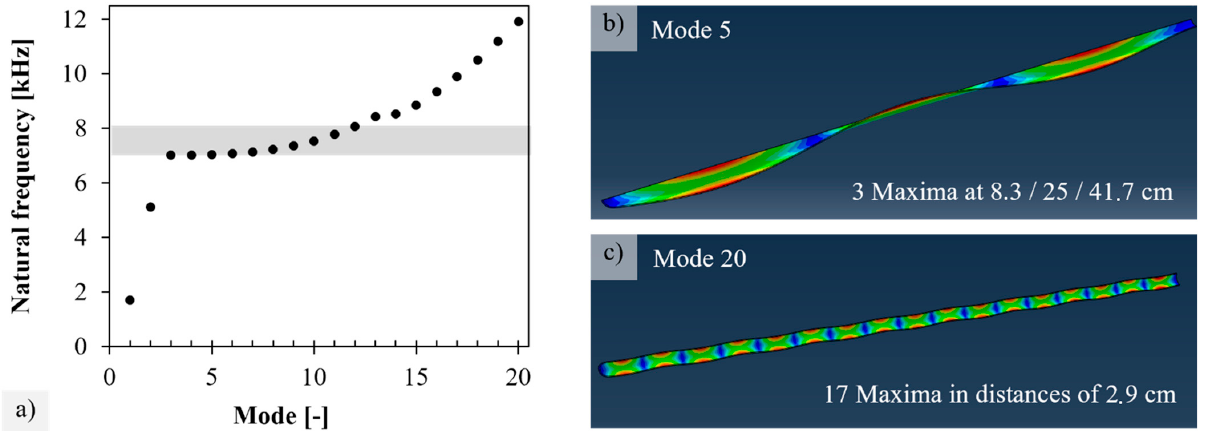
Figure A6. ( a ) Determined eigenfrequencies of the first 20 modes as well as exemplary eigenmodes at mode 5 ( b ) and 6 ( c ). The scaling factor of the displacements amounts to 10.